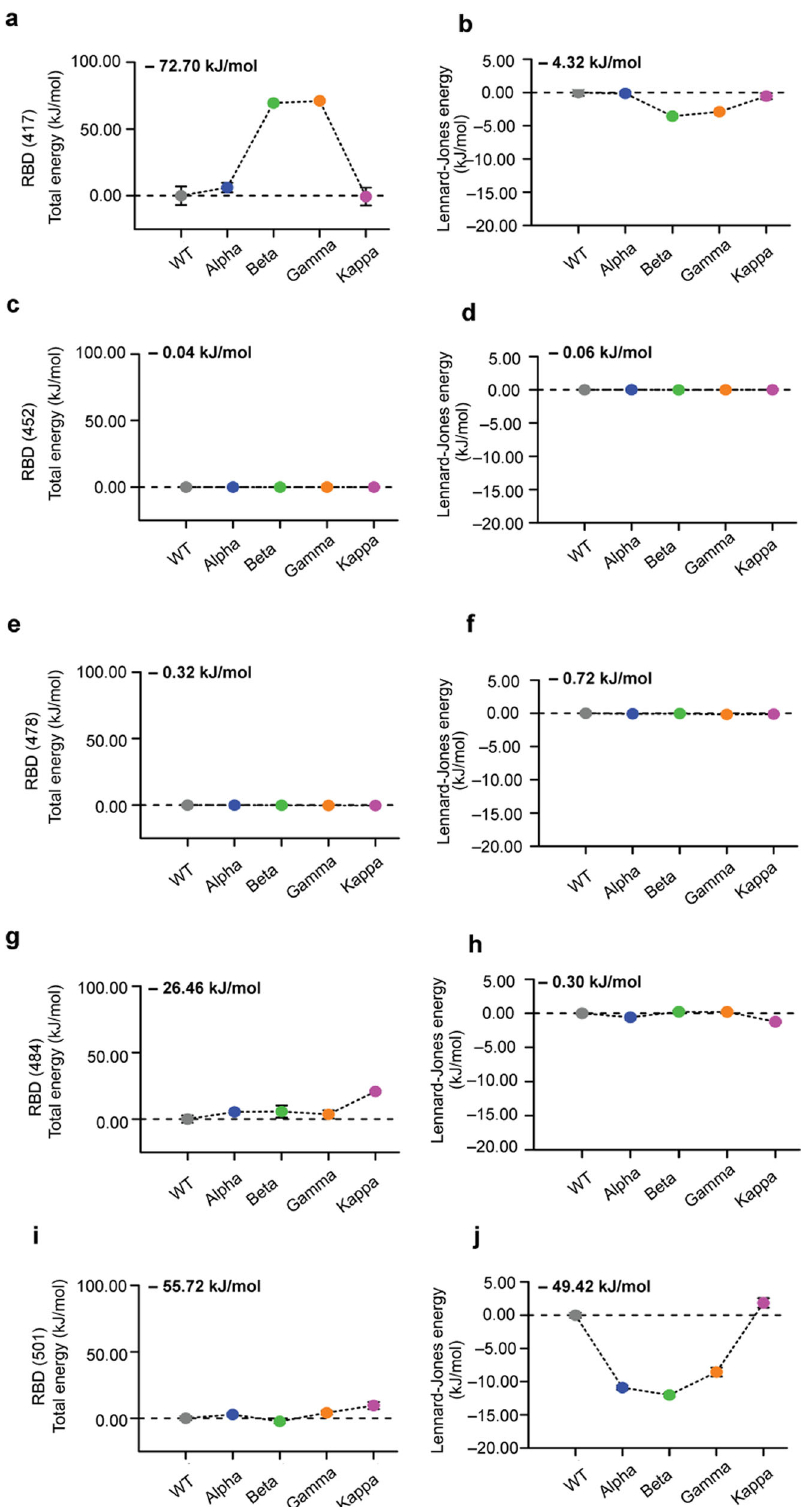
Fig. 4 Energetic analysis of the RBD point mutations through MD simulation. Total energies ( a , c , e , g , i ) and Lennard − Jones ( b , d , f , h , j ) interaction energies between contact ACE2 and RBD residues 417 ( a , b ), 452 ( c , d ), 478 ( e , f ) 484 ( g , h ) and 501 ( i , j ). For ease of comparison, the values have been reset to zero for the WT and the initial value of the WT is shown at the top left. Each point corresponds to the mean energy and the whiskers are the s.d. around the mean value obtained from N = 3130 (WT), N = 2851 (Alpha), and N = 3130 (Beta and Kappa). For most of the data point the error bars are very small and hidden in the symbol. WT is colored in gray, and the VoCs Alpha in blue, Beta in green, Gamma in orange, and Kappa in